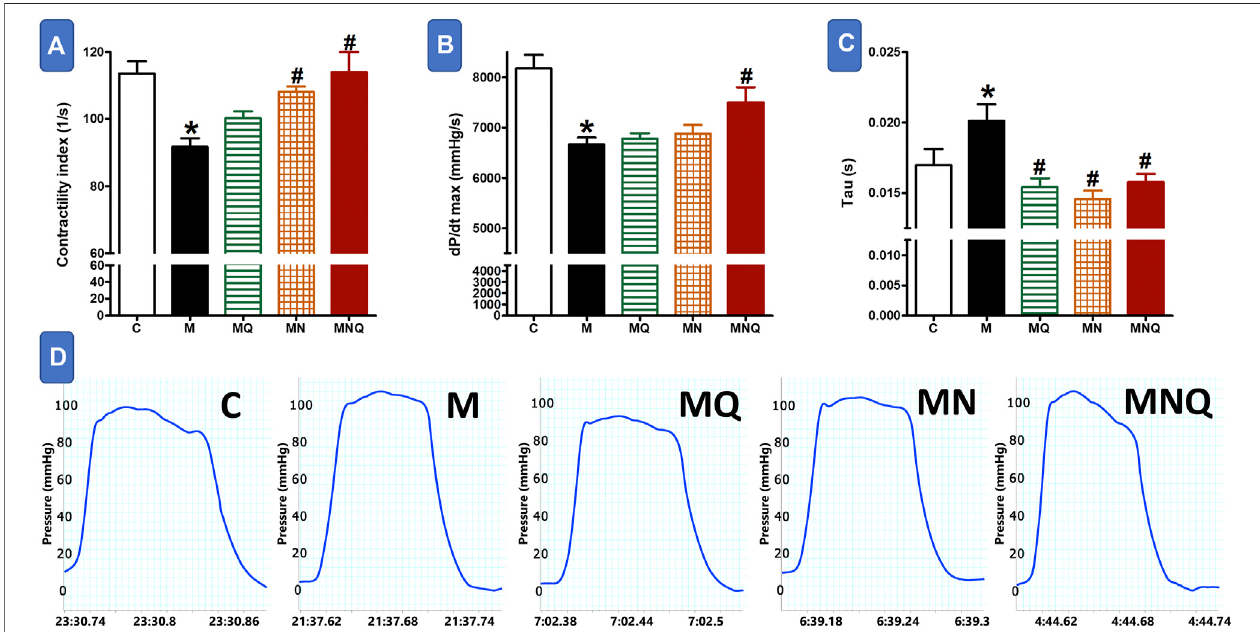
FIGURE 1 | Effect of oral administration of standard quercetin suspension (MQ), plain nano-pharmaceutical formulation (MN) and the quercetin loaded nano- pharmaceuticalformulation(MNQ)bothat83 μ mol/kg/dayoncontractilityindex (A) ,dp/dtmax (B) andTau (C) inmetabolicsyndrome(M)inducedbyfeedingratsahigh fructose (10% in drinking water), high salt (3%), high fat (25%) diet for 12 weeks. Panel D shows representative original recording of ventricular pressure. Results are expressedasmean ± SEM(n (cid:2) 8forallgroups).* p < 0.05whencomparedtothecorrespondingcontrol(C)values,# p < 0.05whencomparedtothecorresponding MetS values using one-way ANOVA followed by Dunnet ’ s post-hoc